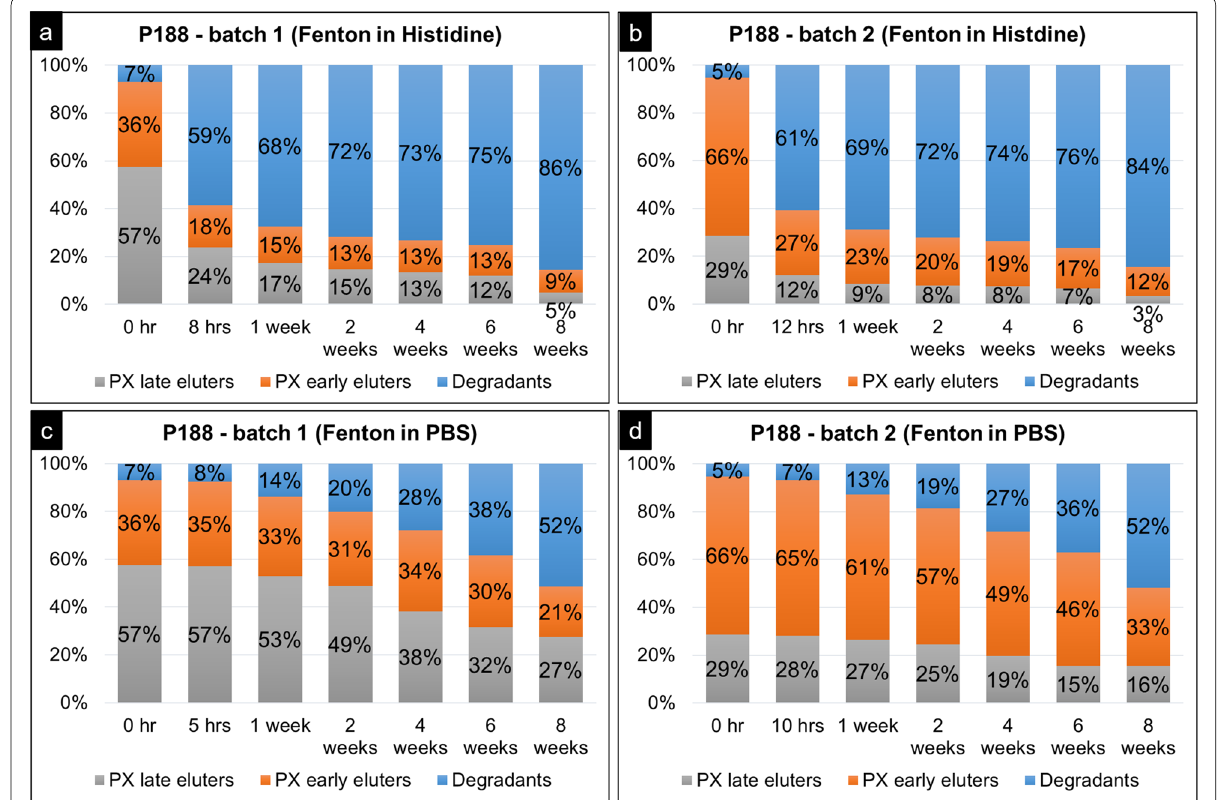
Fig. 3 The degradation of P188 by Fenton in histidine ( a , b ) and PBS buffers ( c , d